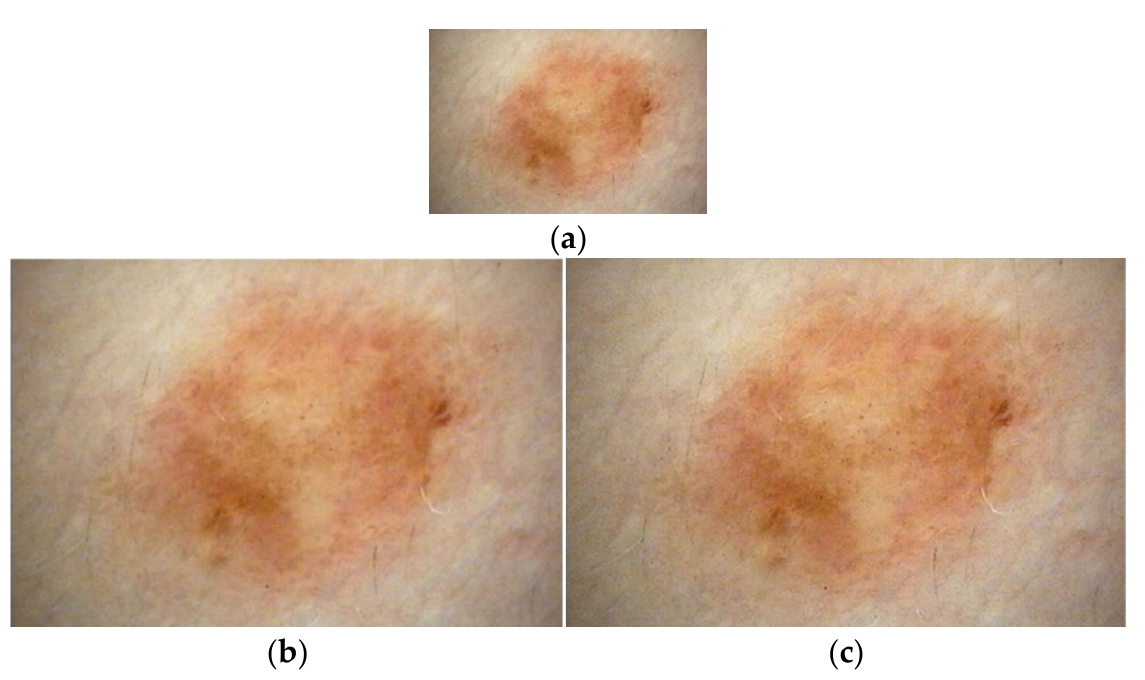
Figure 4. Size enhancement samples ( a ) Original image, ( b ) The bilinear interpolation, ( c ) The proposed VSDR approach.